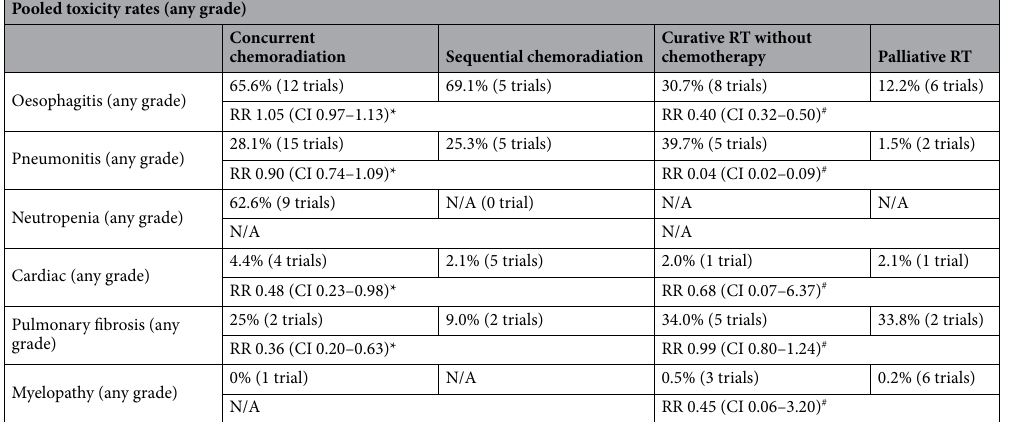
Pooled toxicity rates (any